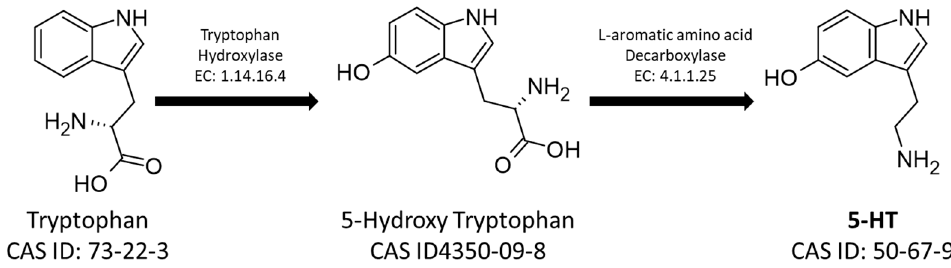
Figure 2. The metabolic pathway for the synthesis of serotonin. The figure shows the CAS-IDs of the molecules along with the EC numbers of the enzymes involved in the biosynthetic pathway.